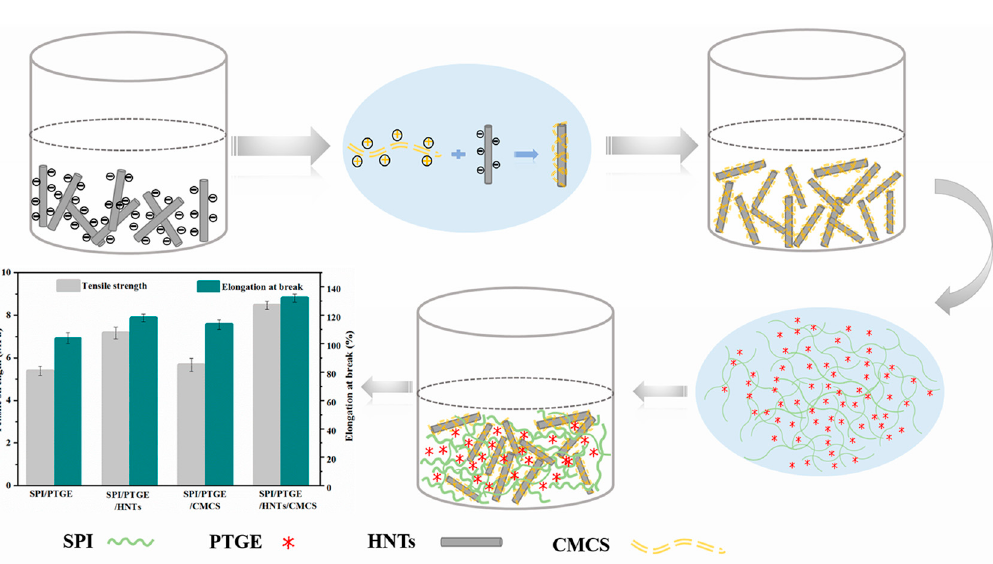
Figure 1. The forming process of the composite films. SPI: Soy Protein Isolate.